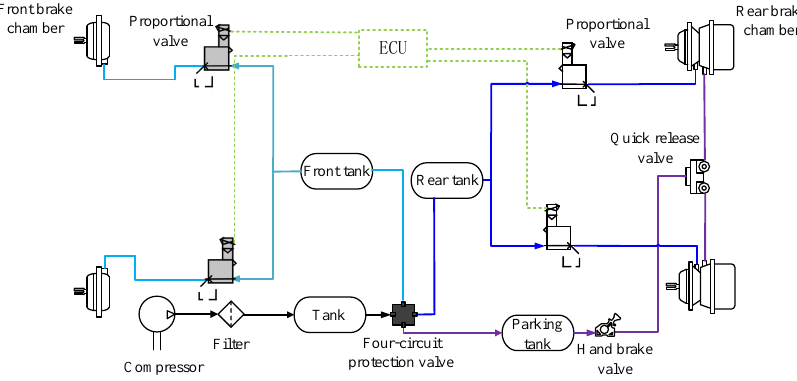
Figure 1. The simplified pneumatic brake system